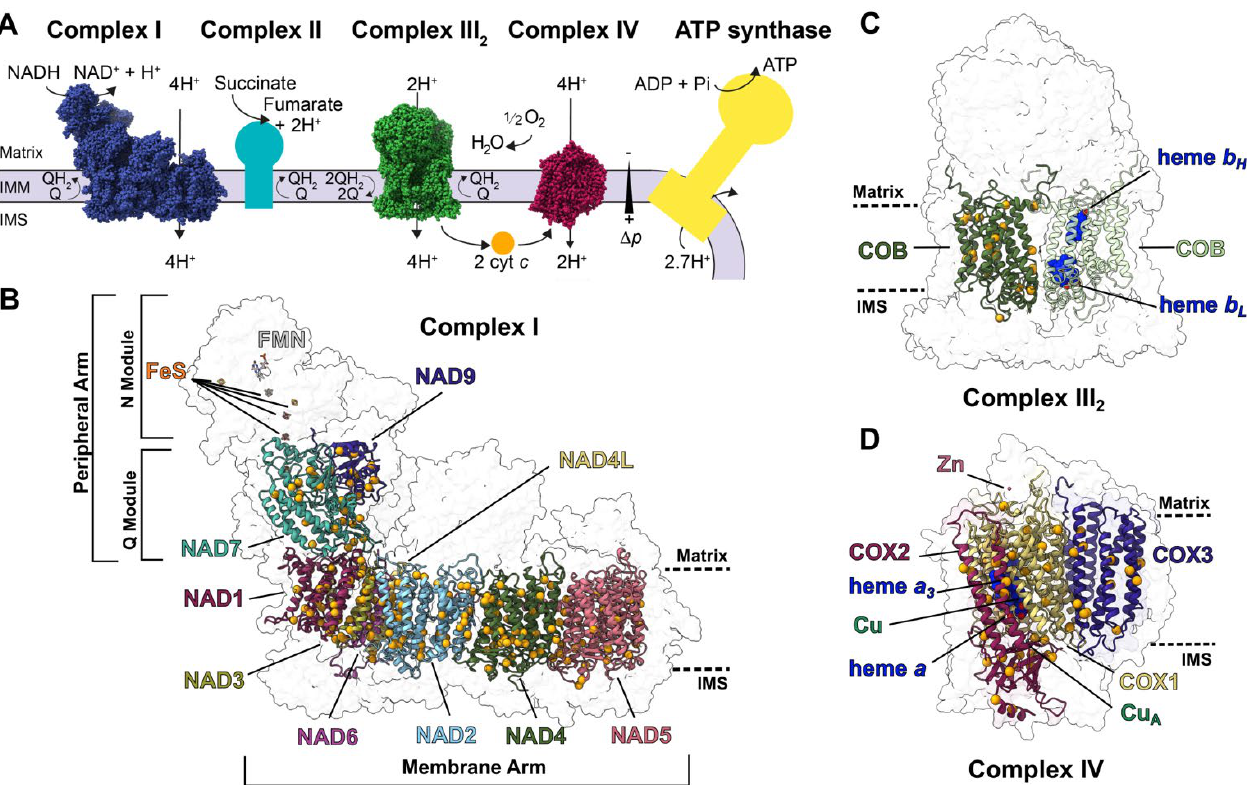
Figure 1. RNA-edited subunits of plant respiratory complexes: ( A ) Schematic overview of the plant canonical respiratory chain. Complexes I-IV and ATP synthase are shown in the inner mitochondrial membrane (IMM). Complex I (blue, PDB: 7AR8), complex III 2 (green, PDB: 7JRG) and complex IV (magenta, PDB: 7JRO) are shown with their atomic structures in sphere representation [11,12]. Com- plexes without structures (complex II, teal; ATP synthase, yellow) are represented in boxes. Sub- strates and products (NADH, NAD + , succinate, fumarate, O 2 , H 2 O, ADP, P i , ATP), electron carriers (quinone, Q; quinol, QH2; cytochrome c , cyt c ), proton pumping stoichiometry (H + ), protonmotive force ( ∆ p), matrix, intermembrane space (IMS) and inner mitochondrial membrane (IMM) are indi- cated. ( B – D ) Subunits of complex I ( B ), complex III 2 ( C ) and complex IV ( D ) that undergo RNA editing are shown in colored cartoons. Edited residues are shown as orange spheres overlayed over the transparent surface of the complex. Approximate locations of the matrix and IMS are shown in dashed lines. ( B ) In addition to the edited subunits, complex I’s flavin mononucleotide (FMN) and iron-sulfur (FeS) co-factors are shown in stick representation. Complex I’s membrane and peripheral arms and approximate locations of the N (NADH-binding) and Q (quinone-binding) modules are marked. ( C ) Both COB subunits of complex III 2 are shown. Dark-green COB highlights the edited residues. Light-green COB highlights the subunit’s heme b H and b L (dark blue spheres). ( D ) Complex IV’s heme a , heme a 3 , Zn 2+ , copper-A (CuA) co-factors are shown in spheres. 2. Approach We structurally characterized the RNA-editing sites of mitochondrially encoded sub- units of plant respiratory-chain complexes for which there are high-resolution structures, i.e., complex I, complex III 2 and complex IV. These subunits are NAD1, NAD2, NAD3, NAD4, NAD4L, NAD5, NAD6, NAD7, NAD9 in complex I, COB in complex III 2 , and COX1, COX2 and COX3 in complex IV (Figure 1B–D). We first used standardized litera- ture searches to create a near-comprehensive list of experimentally identified sites across land plants, determining both the genomically encoded and the edited residues. We then examined the degree of conservation of the edited residues in plants and in a broad range of prokaryotic and eukaryotic model organisms used in respiratory chain research, as well as in humans ( Paracoccus denitrificans , Saccharomyces cerevisiae , Yarrowia lipolytica , Drosoph- ila melagonaster , Homo sapiens ). Next, we mapped each edit to the available structures of complex I ( Arabidopsis thaliana , PDB: 7AR8) [12], complex III 2 ( Vigna radiata , PDB: 7JRG )